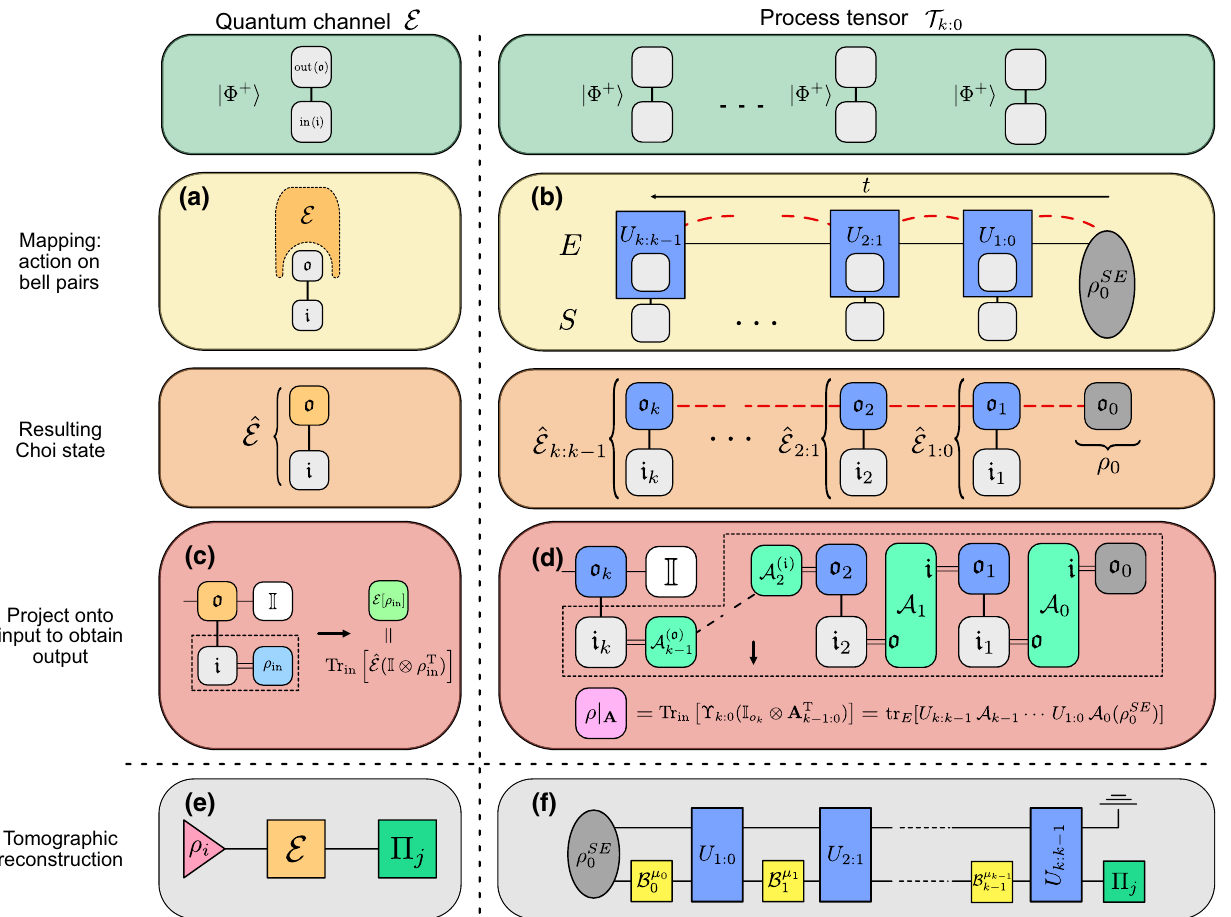
FIG. 2. Operation, manipulation, and characterization analogs between quantum process tomography and process tensor tomogra- ˆ E using the action of E on one half phy. (a) The Choi-Jamiolkowski isomorphism represents a quantum process E by the density matrix of a maximally entangled state. (b) In the generalized CJI, SE unitaries act on one half of a maximally entangled state per time step. Correlations between times (denoted using red dashed lines) are then mapped onto spatial correlations between each output leg of a Bell pair. The result is a collection of (possibly correlated) CPTP maps, as well as the average initial state. (c) The outcome of E on some I ⊗ ρ T ρ and tracing over the input space. (d) The outcome of a process conditioned on in is obtained by projecting the Choi state onto (cid:2) in A k − 1 a sequence of operations A k − 1:0 is obtained by projecting the Choi state of ϒ k :0 onto the Choi state i and tracing over the input. i = 0 ˆ E experimentally, Each A i maps the output state of the i th CPTP map to the input leg of the ( i + 1 ) th CPTP map. (e) To reconstruct prepare a complete set of states { ρ i } , apply E , and reconstruct the output state with an IC POVM { (cid:4) j } . (f) To reconstruct ϒ k :0 , measure μ j } at each time. Note that the blue unitaries here are symbolic each final state of the system subject to a complete basis of CP maps { B j of any SE interactions and not gates that need to be